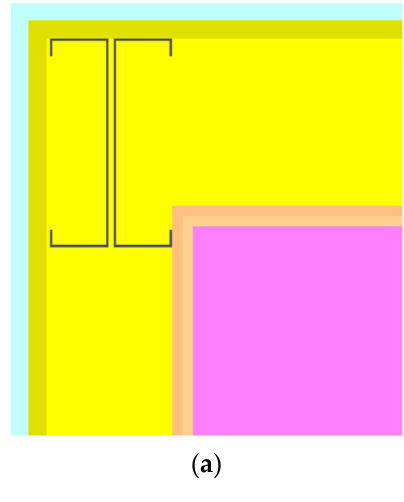
Figure A2. Exterior corner: ( a ) Geometrical models; ( b ) Isothermal surfaces.